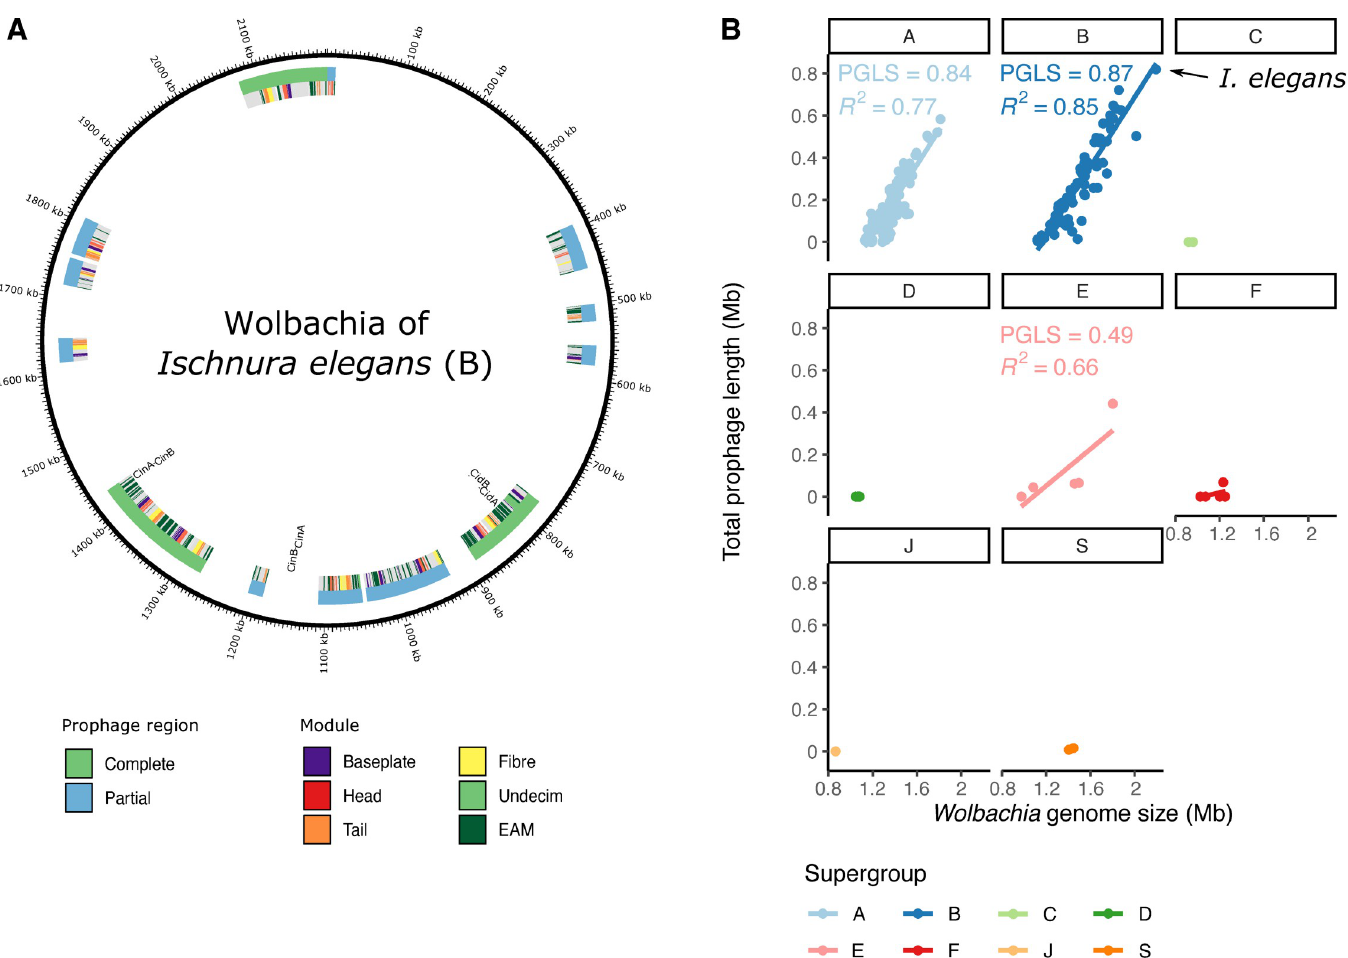
Fig 5. WO prophage in Wolbachia . (A) Annotation of the WO prophage integrated in the genome of the Wolbachia strain infecting Ischnura elegans . (B) Wolbachia genome size is strongly correlated with integrated prophage span in supergroups with WO phage association. Phylogenetic generalised least squares (PGLS) analyses were performed to assess the correlation between prophage length and genome size in a phylogenetically aware manner. The data underlying this Figure can be found in S1 Data.